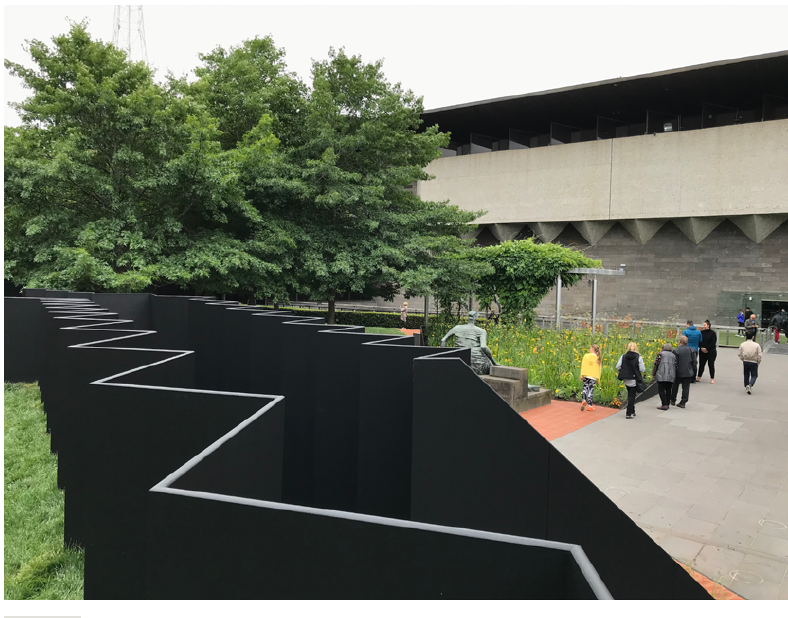
Muir + Openwork, 2018 NGV Architecture Commission Doubleground. National Gallery of Victoria, Melbourne. Source: Photograph by Susan Holden,